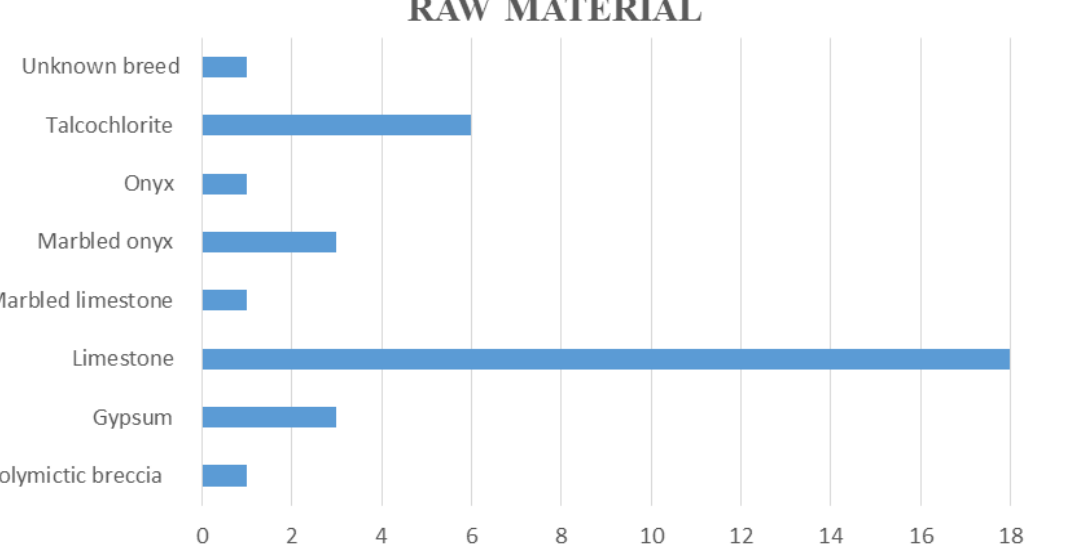
Figure 3. Types of raw materials from which studied miniature columns from Gonur Depe are